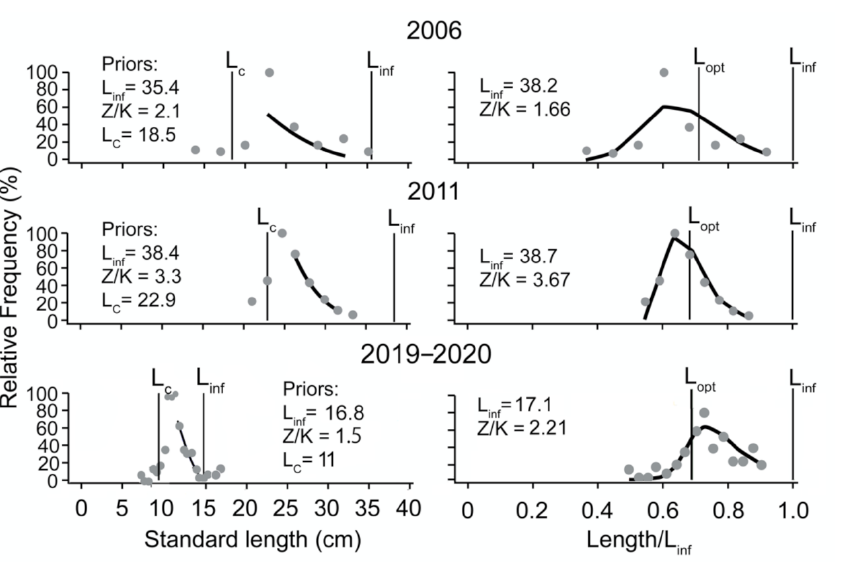
Figure 4. LBB estimation of C. nasus in the Yangtze River Estuary. The panels on the left show the length-frequency (L/F) data from which priors are estimated for L c , L inf and Z / K. The panels on the right show the fit of the LBB master equation to the L/F data, which provides estimates of Z / K , M / K , F / K , L c , and L inf , with L opt computed from L inf and M / K